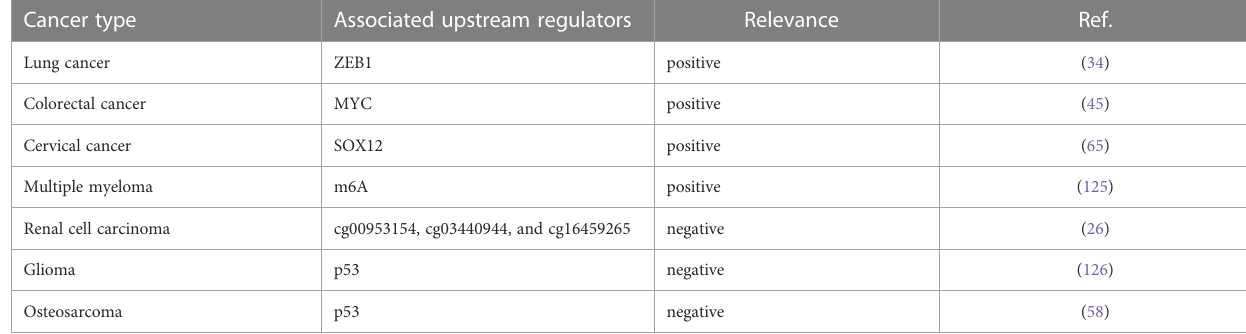
TABLE 4 Upstream regulators of SNHG15 in